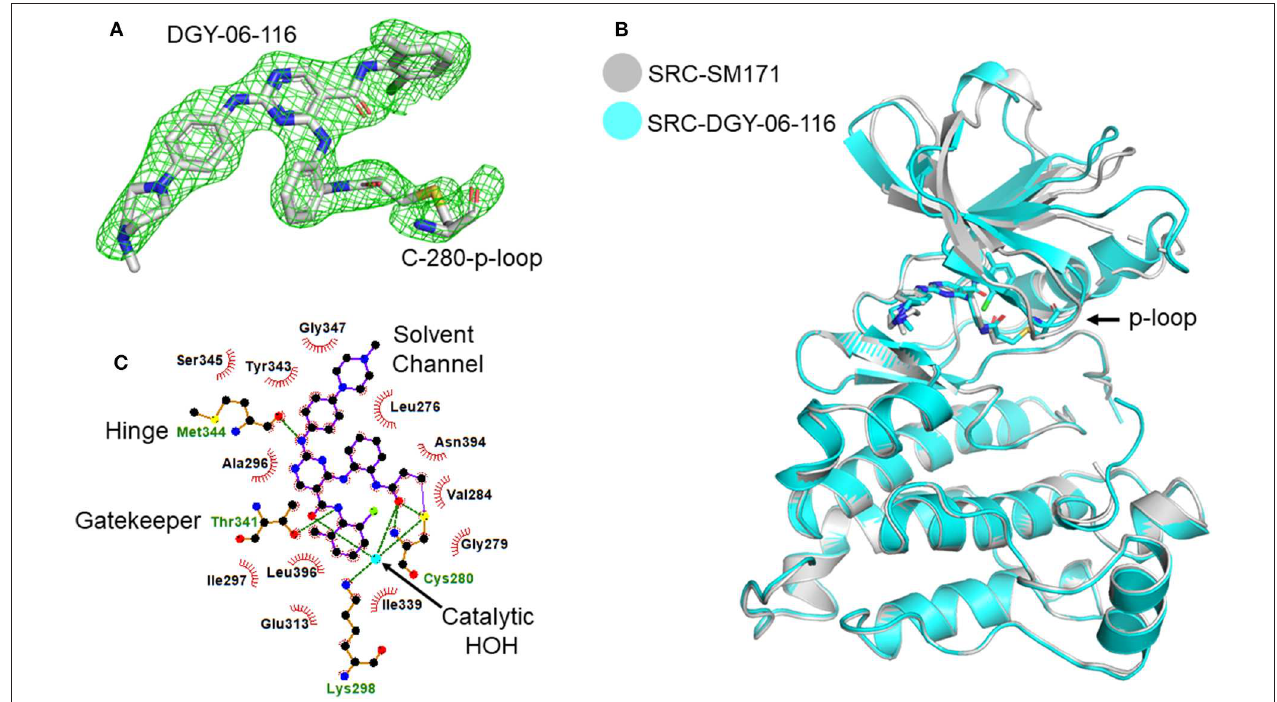
FIGURE 3 | Structural characterization of the Src-DGY-06-116 complex. (A) A F o - F c map at 2.5 σ shows continuous electron density observed for DGY-06-116 forming a covalent linkage to Cys-280 of the p-loop. (B) DGY-06-116 binding to Src kinase leads to bending of p-loop Cys-280 consistent with design. (C) Two-dimensional representations of interactions between DGY and Src kinase domain residues. Hydrogen bonds are shown as green dashes. Hydrophobic interactions are shown as red spikes.